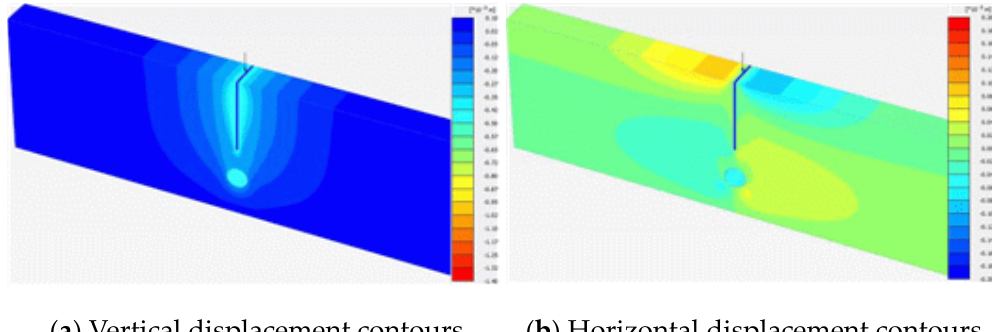
Figure 19. Displacement contours for allowable load (case 1-0).